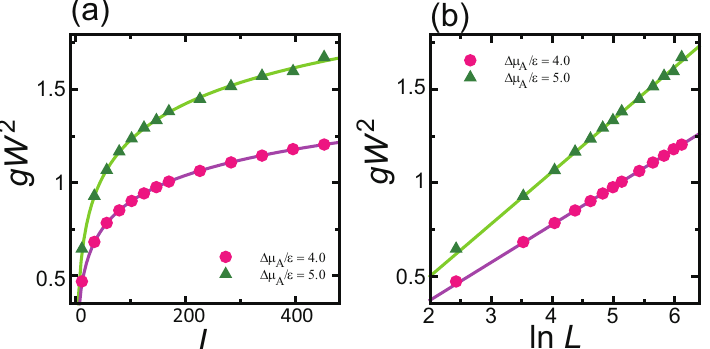
Figure 9. ( a ) Size dependence of squared surface width gW 2 . ( b ) Semi-logarithmic plots of gW 2 . k B T / (cid:101) = 0.2. Averaged over 2 × 10 8 MCS/site. Lines are obtained from Equation (22).